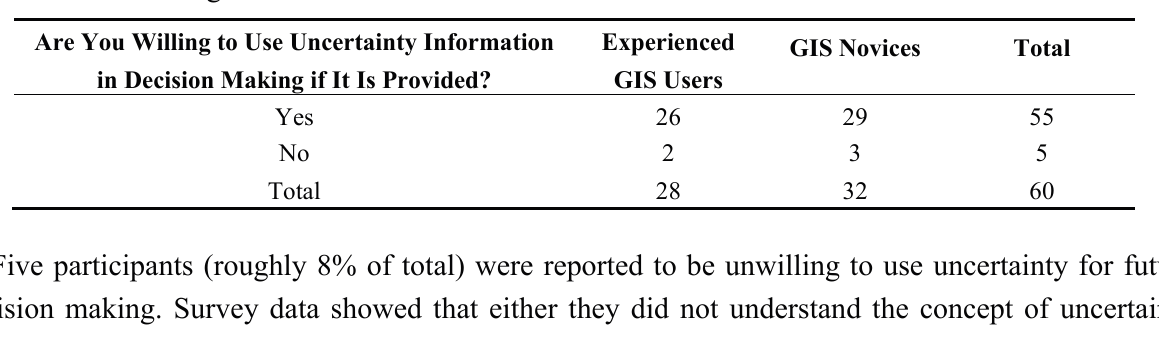
Table 4. Observed frequencies on willingness to use uncertainty information in decision